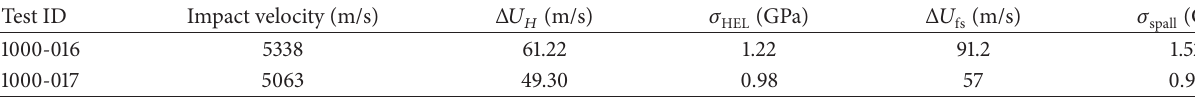
Table 5: Hugoniot elastic limit and spall strength.